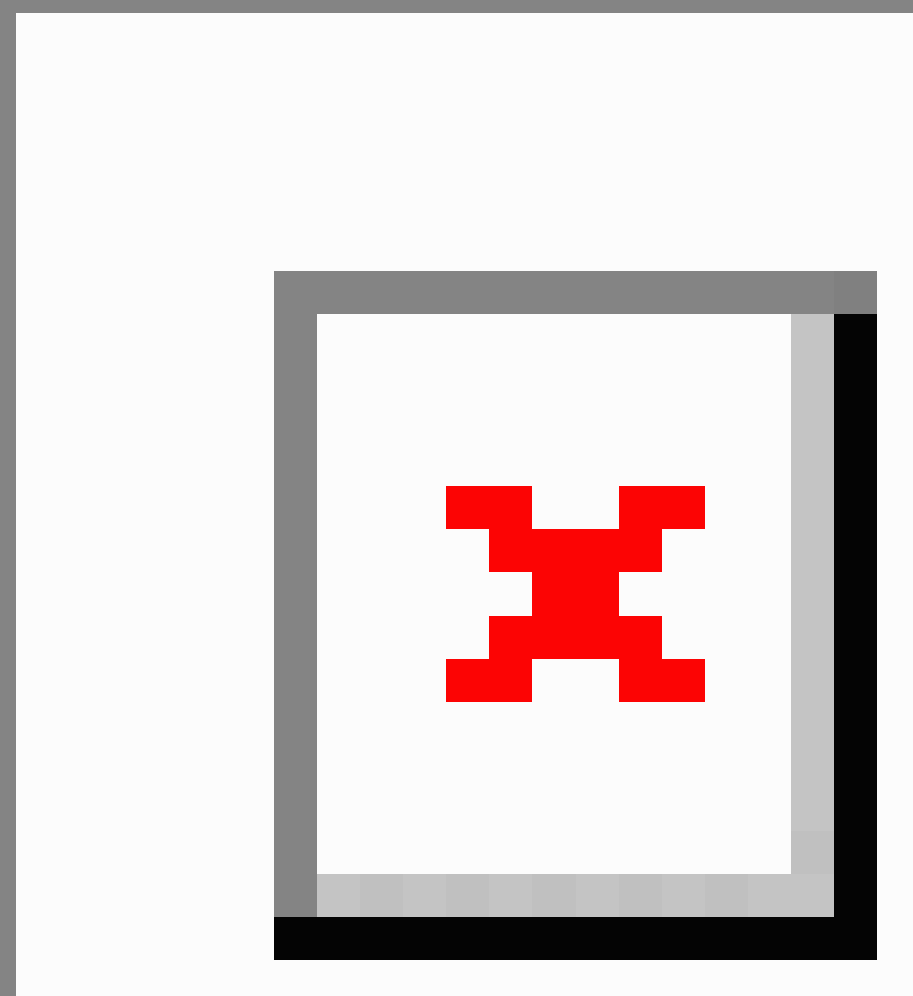
Figure 1. Participant’s self-reported experience using telehealth